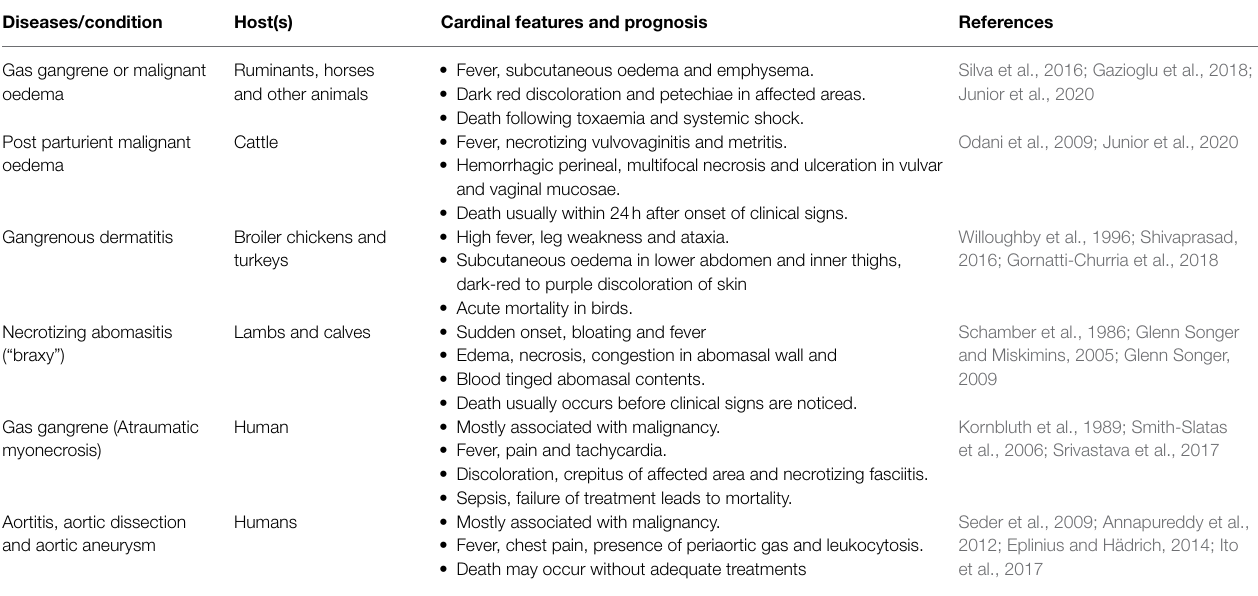
TABLE 1 | List of selected disease reports and conditions in humans and animals that are mainly linked to C. septicum . Diseases/condition Host(s) Cardinal features and